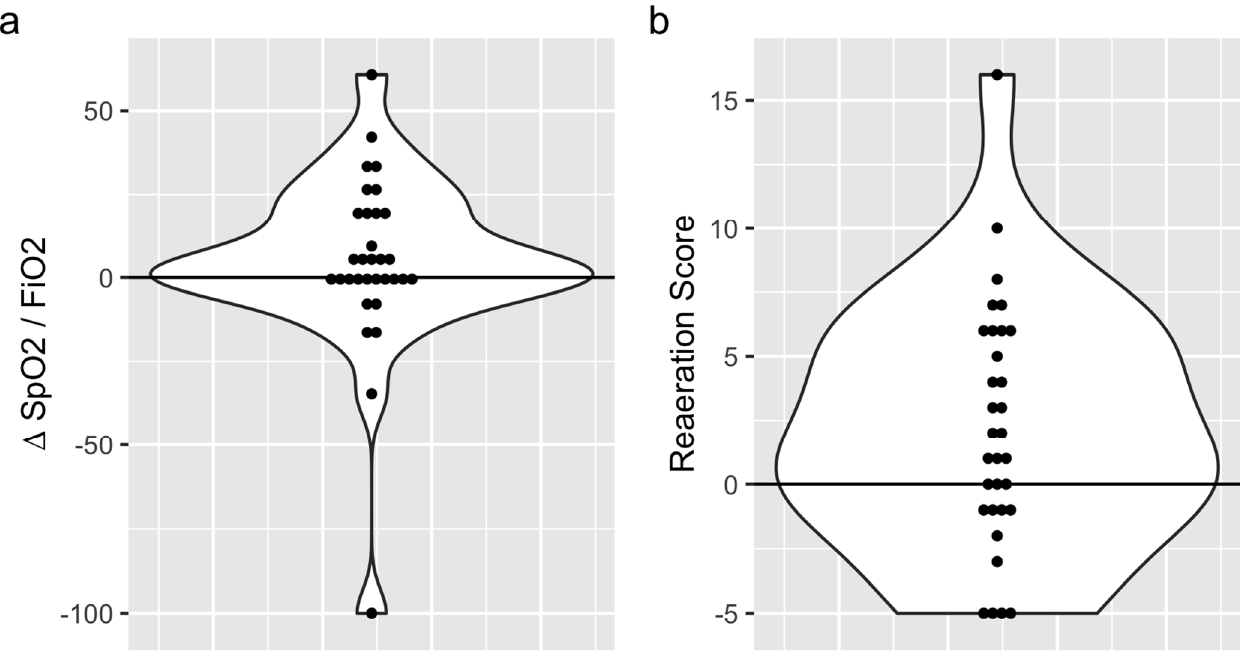
Figure 2. Variations in the SpO 2 :FiO 2 ration ( a ) and reaeration score ( b ) after the chair trial in the whole cohort.